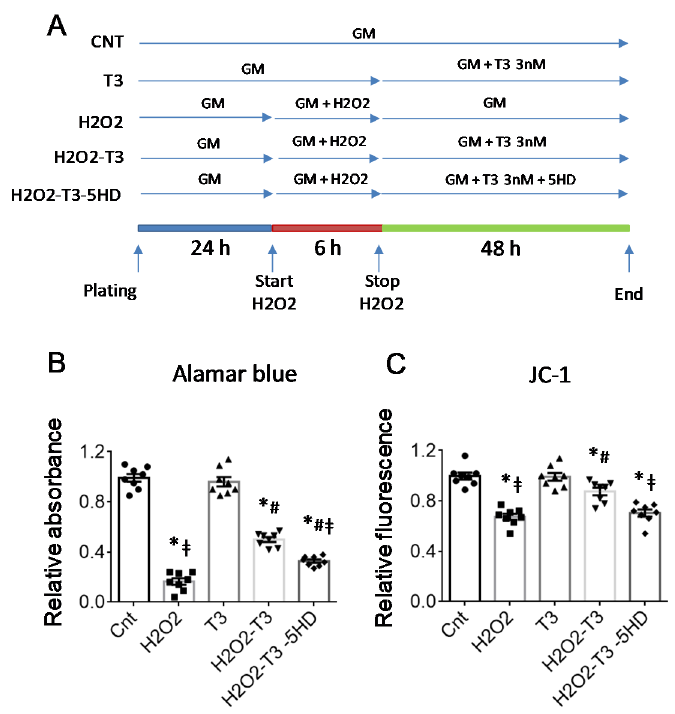
Figure 3. The pharmacological inhibition of mitoK-ATP reduces the protective effect of T3 against cell death and alterations to the inner mitochondrial membrane potential. ( A ) Schematic representation of the experimental protocol. GM = growth medium, 5HD = 5 -Hydroxydecanoate. ( B ) Viability test; and ( C ) JC1 assay in NRCM stressed for 6 h with 300 µ M H 2 O 2 and then treated with 3 nM T3 or its vehicle for 48 h. n = 8, * p < 0.0001 vs. Cnt and T3; # p ≤ 0.001 vs. H 2 O 2 ; ‡ p ≤ 0.02 vs. H2O2-T3.